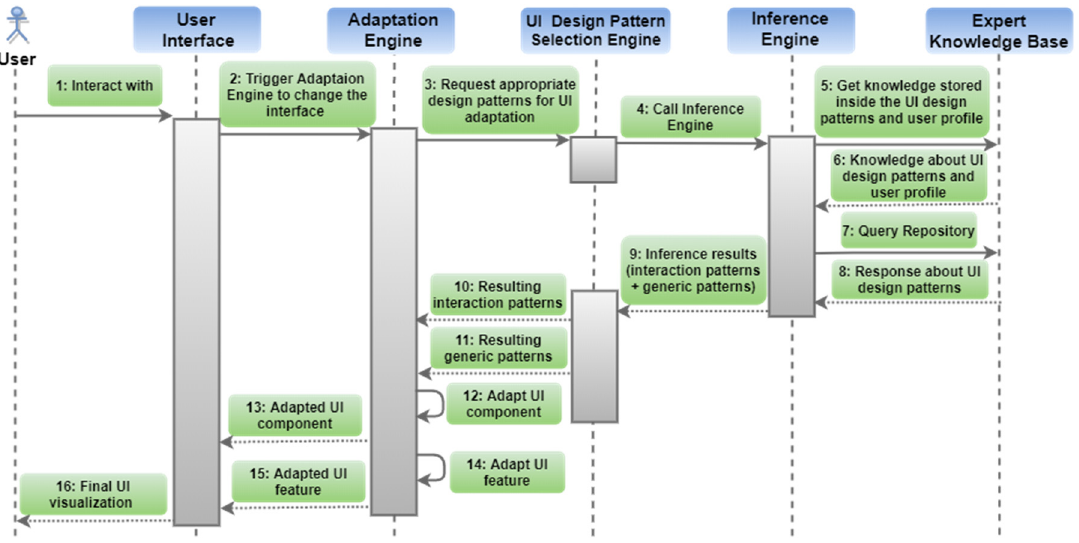
Figure 5. Sequence diagram representing the UI adaptation